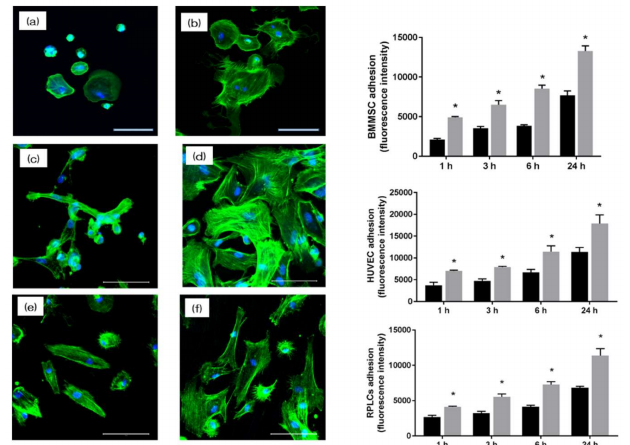
Figure 5. The morphology of rat bone marrow cells (RBMCs) ( a , b ), human umbilical vein endothelial cells (HUVECs) ( c , d ), and rat periodontal ligament cells (RPLCs) ( e , f ) on the surface of NANOZR after 24 h (RBMCs and RPLCs) and 6 h (HUVECs) of culture was observed with a fluorescence microscope (scale bar: 200 µ m). At the same time, on the material surface of the experimental group, an increase in the number of cells and elongation of cell projections was observed as compared with the control group. In this experiment, the cell morphology was observed and the number of cells on the surface of each material was compared. At all measurement times, the adhesion number of RBMCs, HUVECs, and RPLCs in the test group was significantly higher than that in the control group. (Gray bar—untreated surface, black bar—UV-treated surface). (*: p <